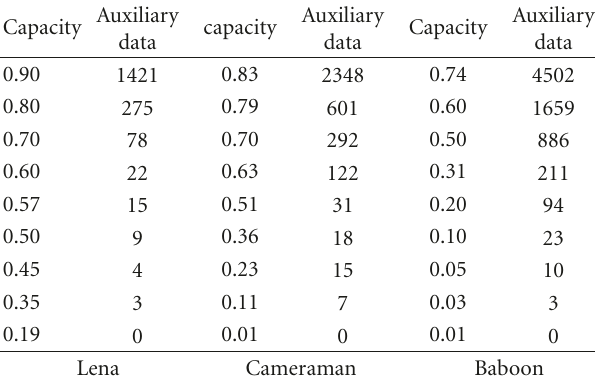
Table 1: The number of auxiliary data in the proposed method.